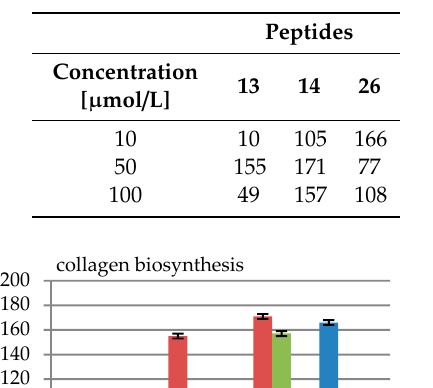
Table 5. Collagen biosynthesis (% of Control ± 2).